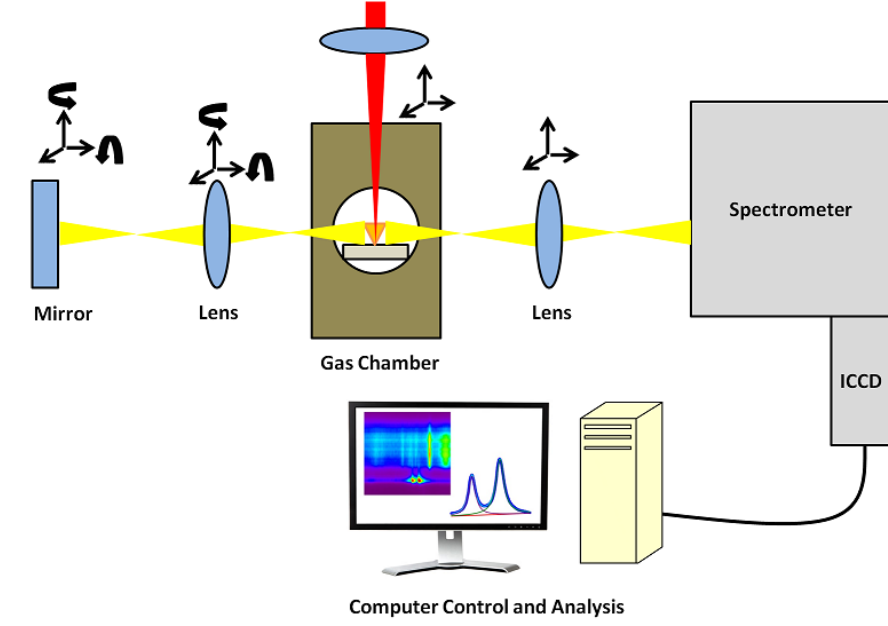
Figure 2. Block diagram of the experimental apparatus detailing self-absorption